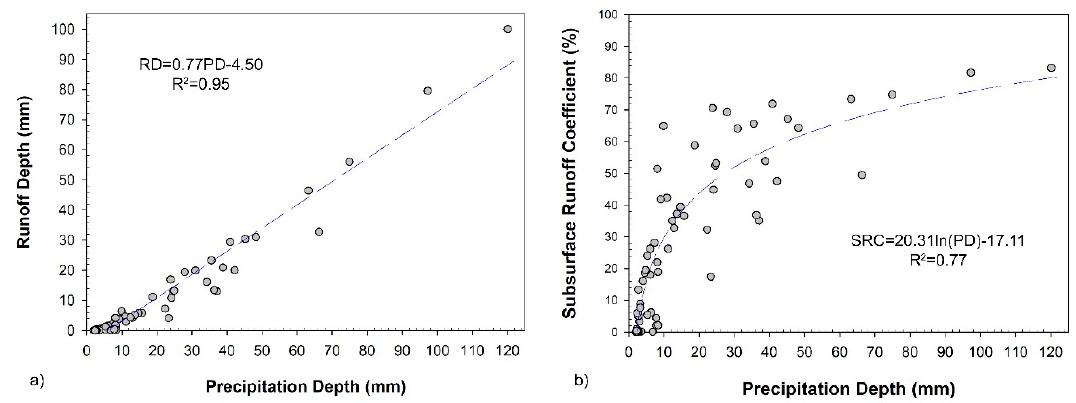
Figure 2. Regression plots (significance level = 0.05) for selected key parameters, by using all the rainfall events: ( a ) runoff depth (RD) as a function of precipitation depth (PD) and ( b ) subsurface runoff coefficient (SRC) as a function of precipitation depth (PD).